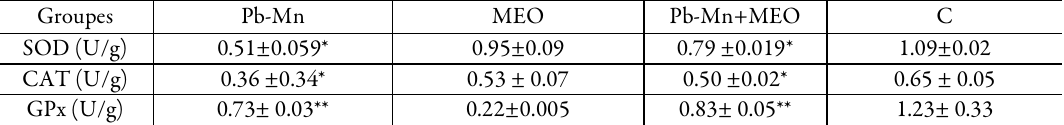
Table 3. Effect of M. spicata essential oil in the activity of anti-oxidant enzymes in kidney of rats